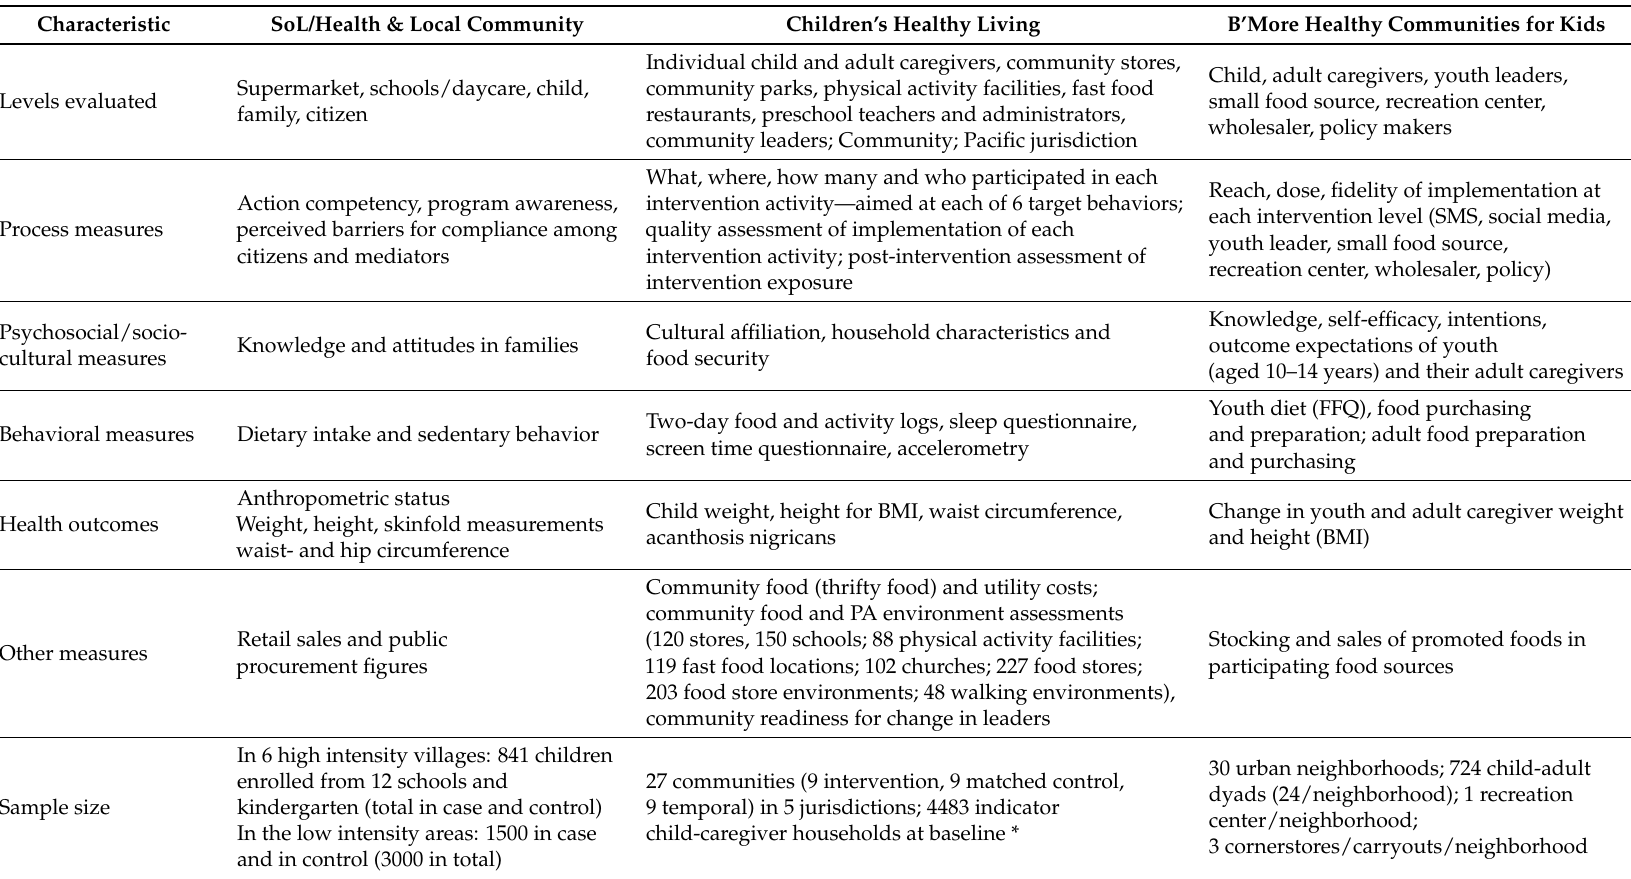
Table 3. Evaluation strategies of the three Multilevel-Multicomponent (ML-MC) community-based intervention